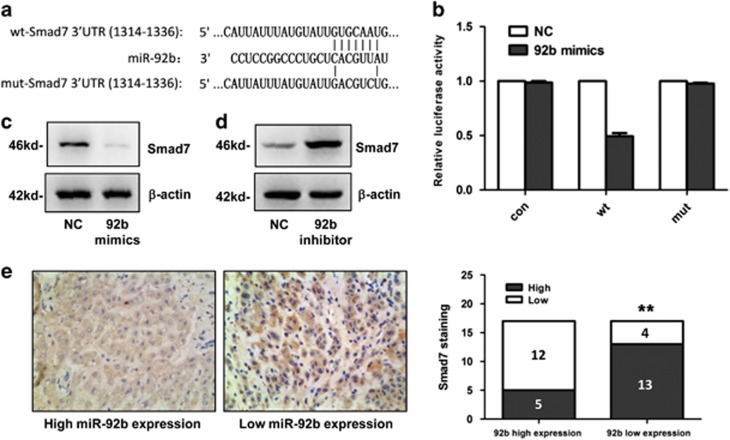
Smad7 is a direct target of miR-92b in HCC. (a) Diagram of the miR-92b putative binding sites and corresponding mutant sites in the 3′-UTR of Smad7 (wt, wild-type; mut, mutant type). (b) Effects of miR-92b on the expression of Smad7 3′-UTR-containing reporter genes. Each luciferase activity was normalized to the value obtained in the cells transfected with NC mimics. Results were represented as mean±S.D. (n=3). (c and d) Western blot analysis of Smad7 expression in SMMC-7721 cells with miR-92b mimics transfected and HCCLM3 cells with miR-92b inhibitor transfected. (e) Left Panels: representative immunohistochemistry images showing the expression of Smad7 (brown color) in HCC tissues. Right panel: a significant inverse correlation between miR-92b and Smad7 expression in HCC tissues (Spearman's r=−0.4714, **P<0.01)